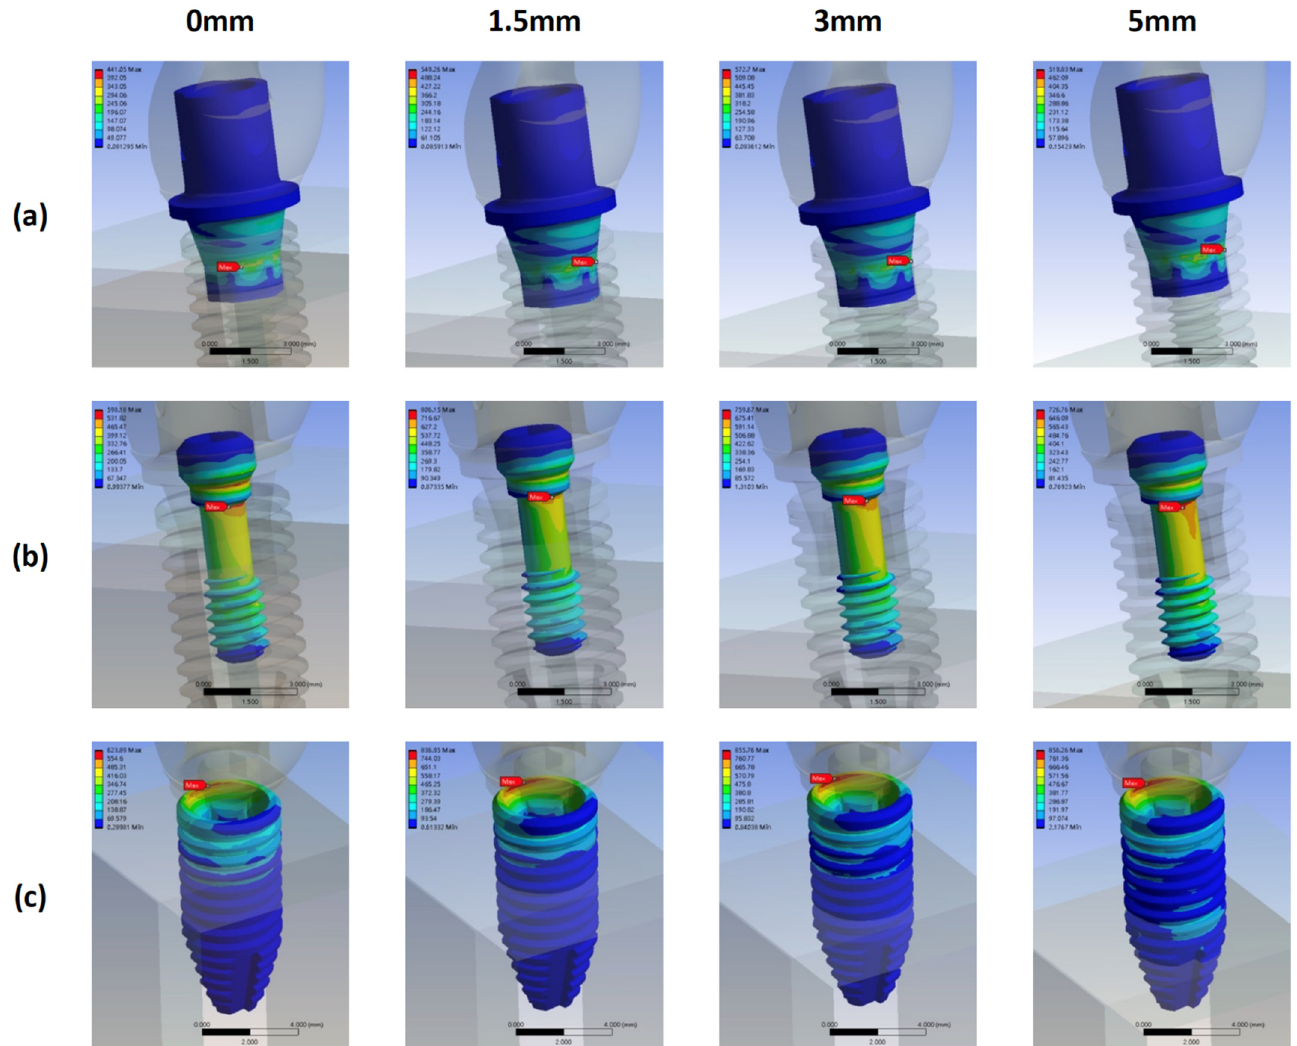
Figure 11. Stress distribution and maximum von Mises stress on the abutment, screw, and fixture in the CT groups with different bone loss levels. ( a ) abutment ( b ) screw ( c ) fixture.